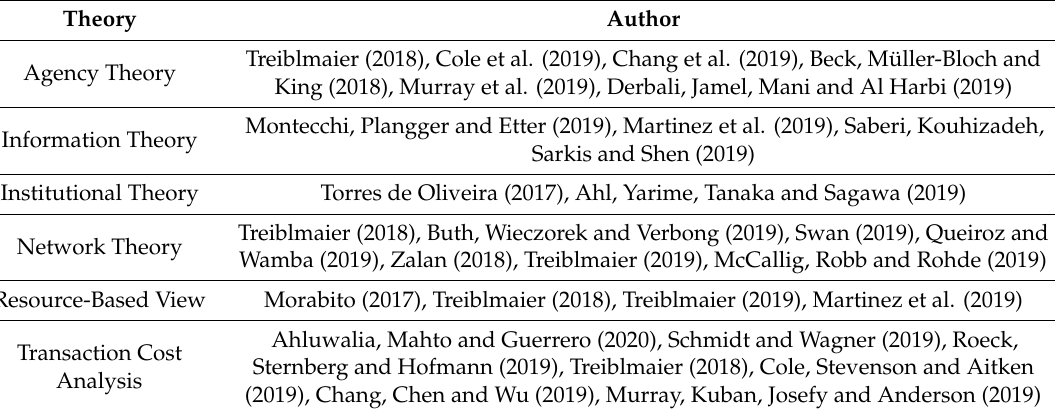
Table 3. Topics by author.